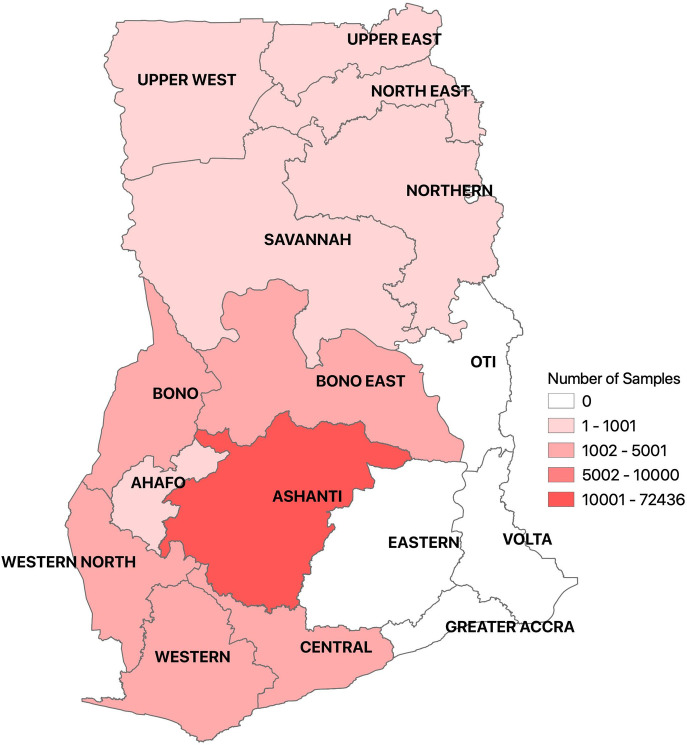
Description of sample sites.